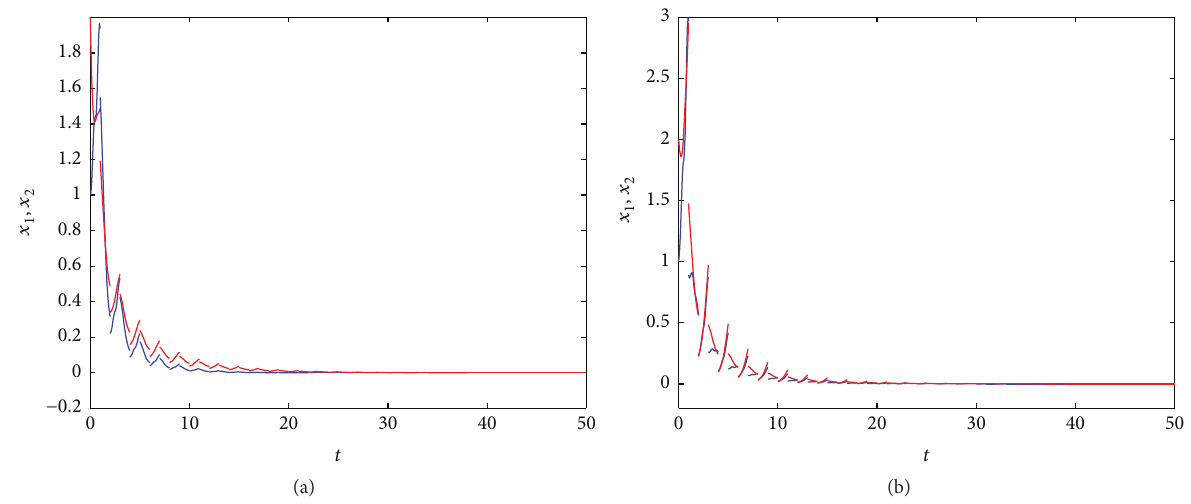
Figure 3: The extinction of the two species 𝑥 1 and 𝑥 2 of system (73). The extinction illustrated in (a) is caused by the austere survival environment of the two patches and the extinction illustrated in (b) is caused by the large loss during the migration ( 𝐷 11 = 0.7, 𝐷 12 = 0.6 , = 0.5 , and 𝐷 = 0.6 ). Here, we take initial values 𝑥 𝐷 21 22